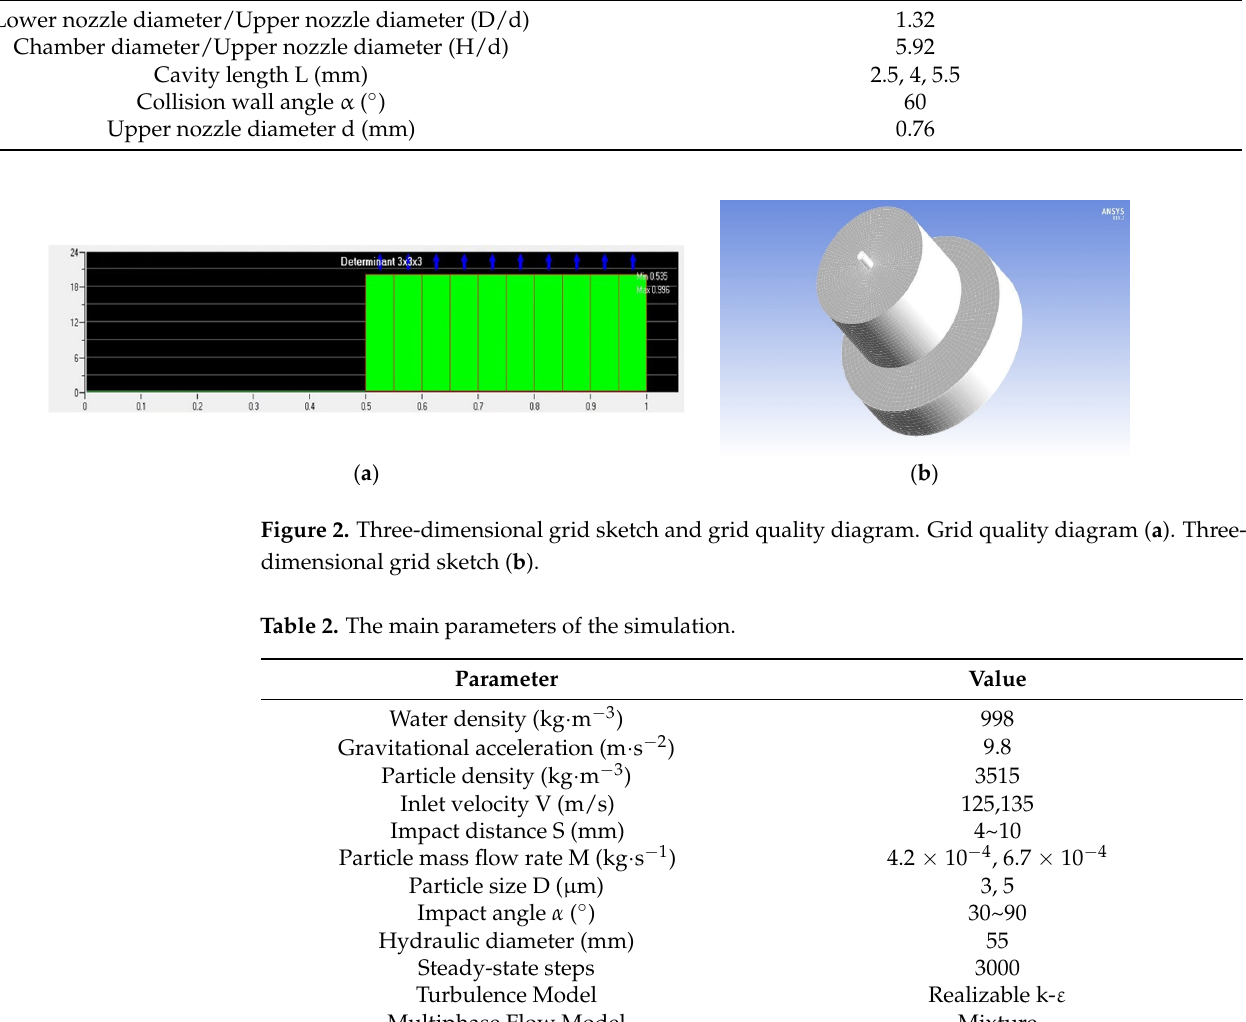
Table 2. The main parameters of the simulation.